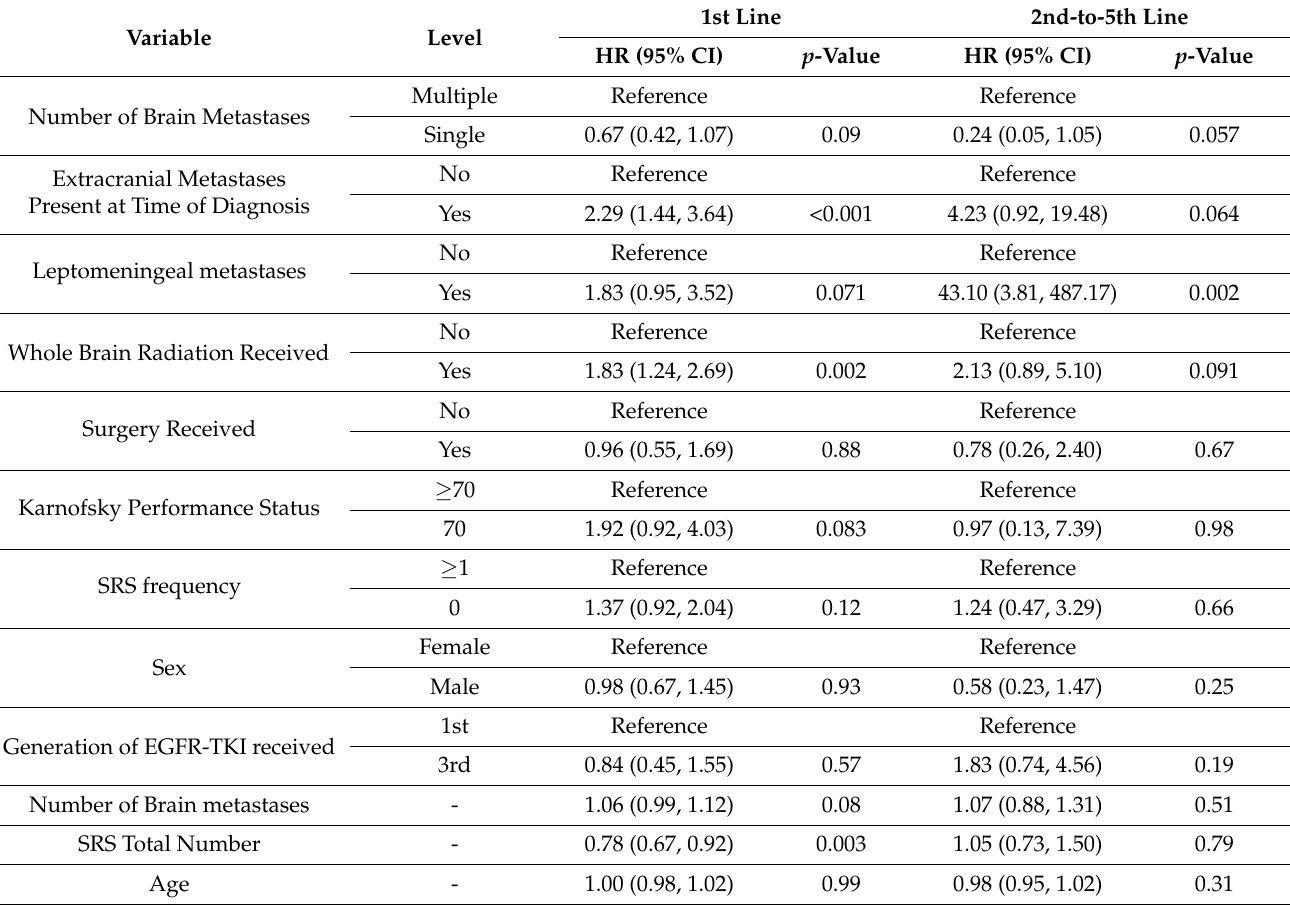
Table 5. Univariable Cox Proportional Hazards modeling of overall survival.